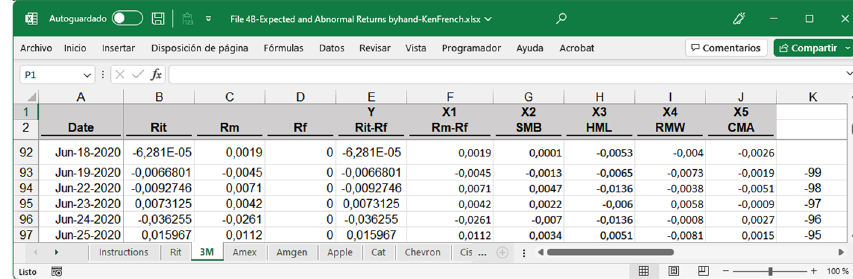
Fig. 7 Partial 3 M spreadsheet structure for running a regression. Source : Created by authors